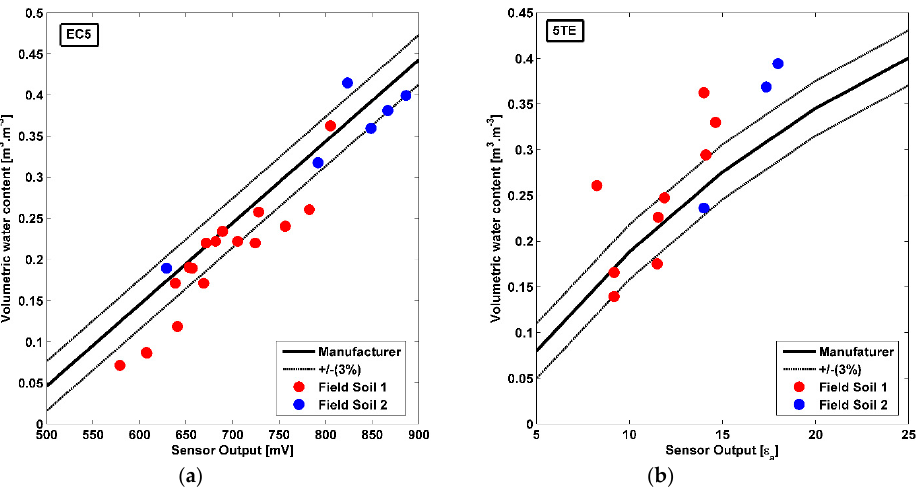
Figure 6. Field calibration results for the ( a ) EC5 and ( b ) 5TE sensors and for Soil 1 and 2 Comparison with the manufacturer equation (± 0.03 m 3 ∙ m − 3 accuracy). with the manufacturer equation ( ± 0.03 m 3 · m − 3 accuracy).